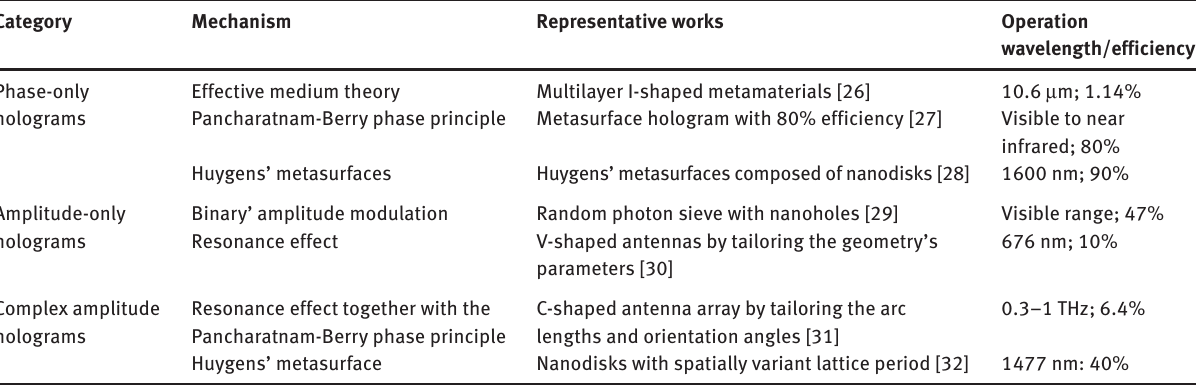
Table 1: Categories of the metasurface holograms.